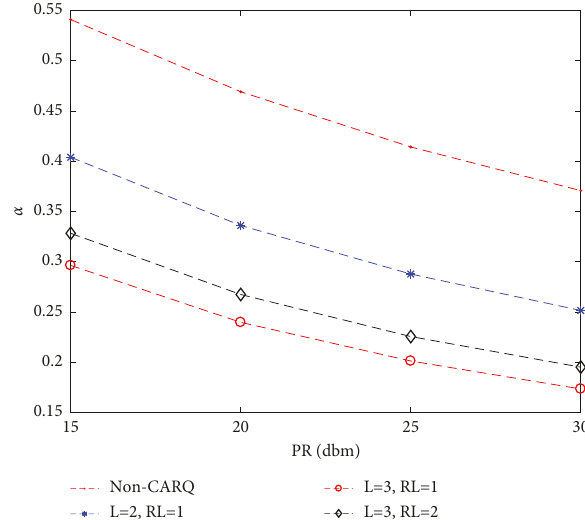
Figure 10: P R vs α with different